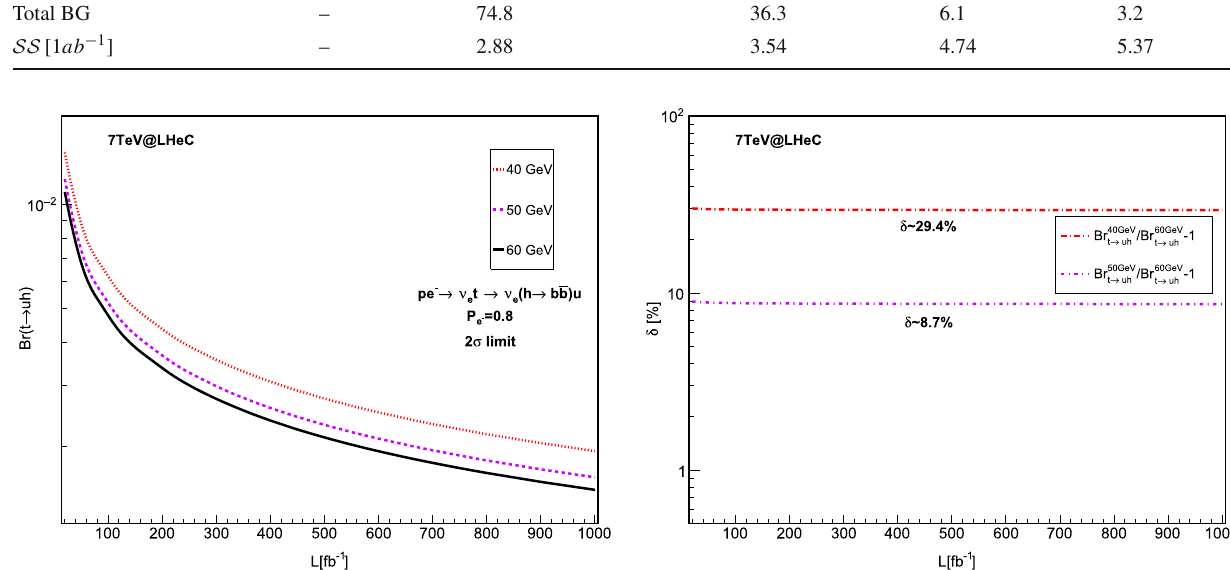
Fig. 7 The left panel is the 2 σ κ tuh limit as a function of the luminosities. The solid black, dashed violet and dotted red curves are for the 60, 50 and 40 GeV LHeC. The right panel is the ratio defined as δ E = Br